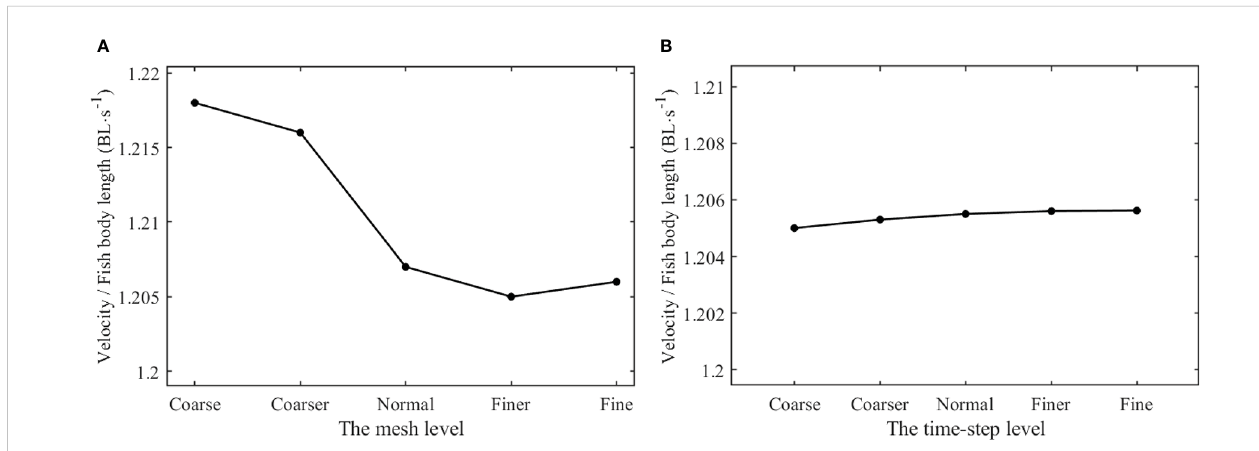
FIGURE 7 The values of nondimensional steady velocity for independence validation. (A) Independence validation of the mesh size (B) Independence validation of the time step.